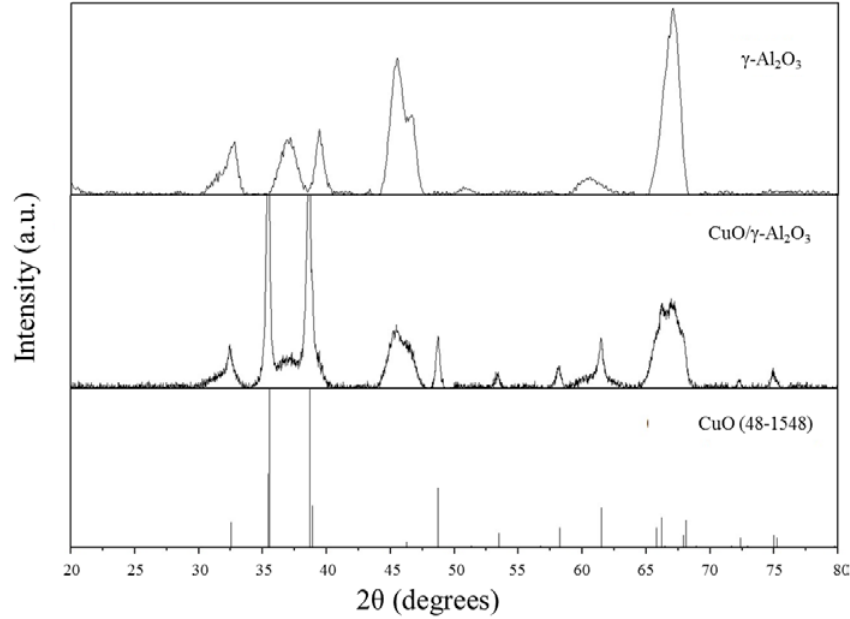
Figure 3. XRD patterns of the CuO/γ -Al 2 O 3 catalysts and the γ -Al 2 O 3 powder.